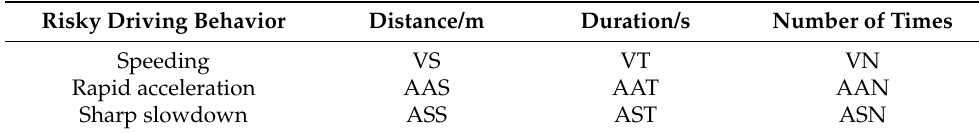
Table 2. Variable definition of various driving behaviors. Risky Driving Behavior Distance/m Duration/s Number of Times Speeding VS VT VN Rapid acceleration AAS AAT AAN Sharp slowdown ASS AST